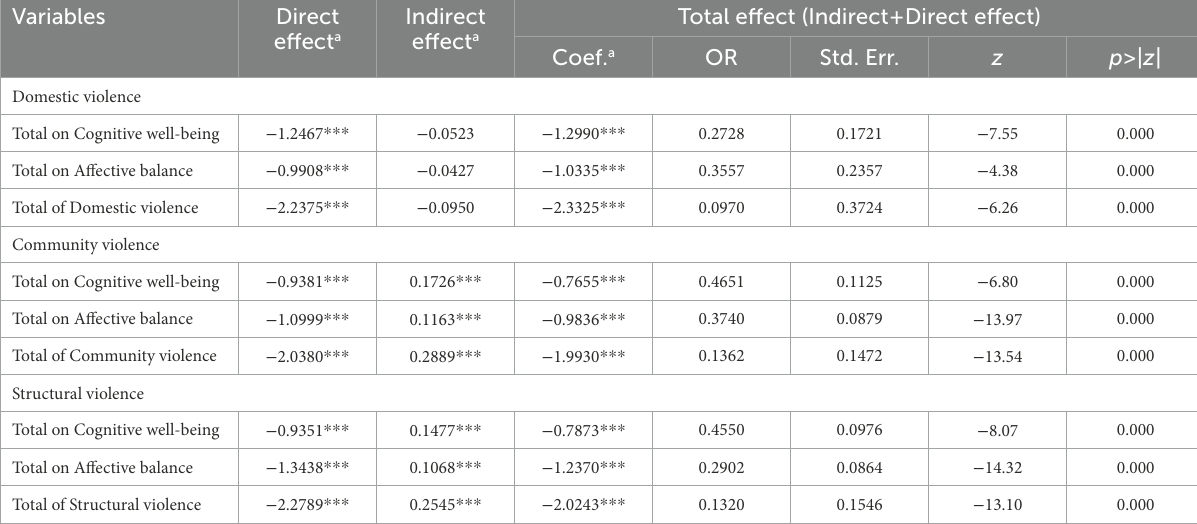
TABLE 6 Mediation test results, total effects of self-perceived victimization variables on subjective well-being dimensions.